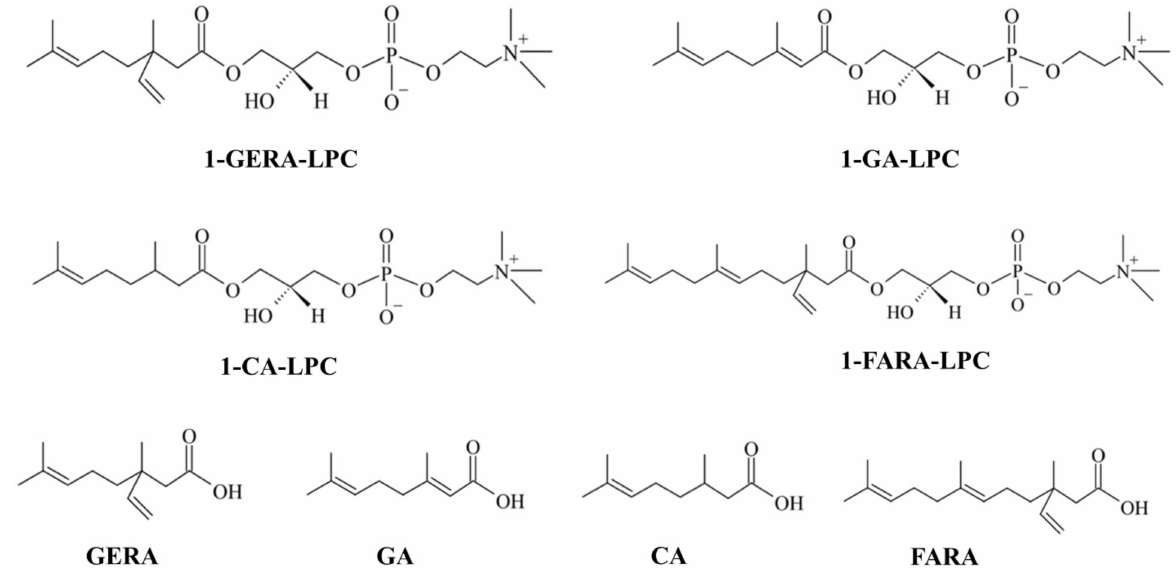
Figure 1. Isoprenoid derivatives of lysophosphatidylcholine: 1 (cid:48) -[3,7-dimethyl-3-vinylocta-6-enyl]-2 (cid:48) -hydroxy-sn- glycero-3 (cid:48) -phosphocholine (1-GERA-LPC), 1-geranoyl-2-hydroxy-sn-glycero-3-phosphocholine (1-GA-LPC), 1-citroneloyl-2- hydroxy-sn-glycero-3-phosphocholine (1-CA-LPC), 1 (cid:48) -[3,7,11-trimethyl-3-vinyldodec-6,10-dienyl]-2 (cid:48) -hydroxy-sn-glycero- 3 (cid:48) -phosphocholine (1-FARA-LPC), free monoterpene acids: 2,3-dihydro-3-vinylgeranic acid (GERA), geranic acid (GA), cytronellic acid (CA), and free sesquiterpene acid: (E)-3,7,11-trimethyl-3-vinyldodeca-6,10-dienoic acid